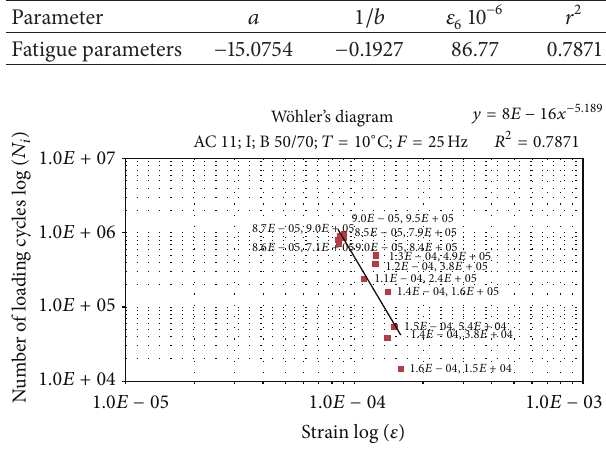
Figure 4: W¨ohler’s diagram for AC 11; I.